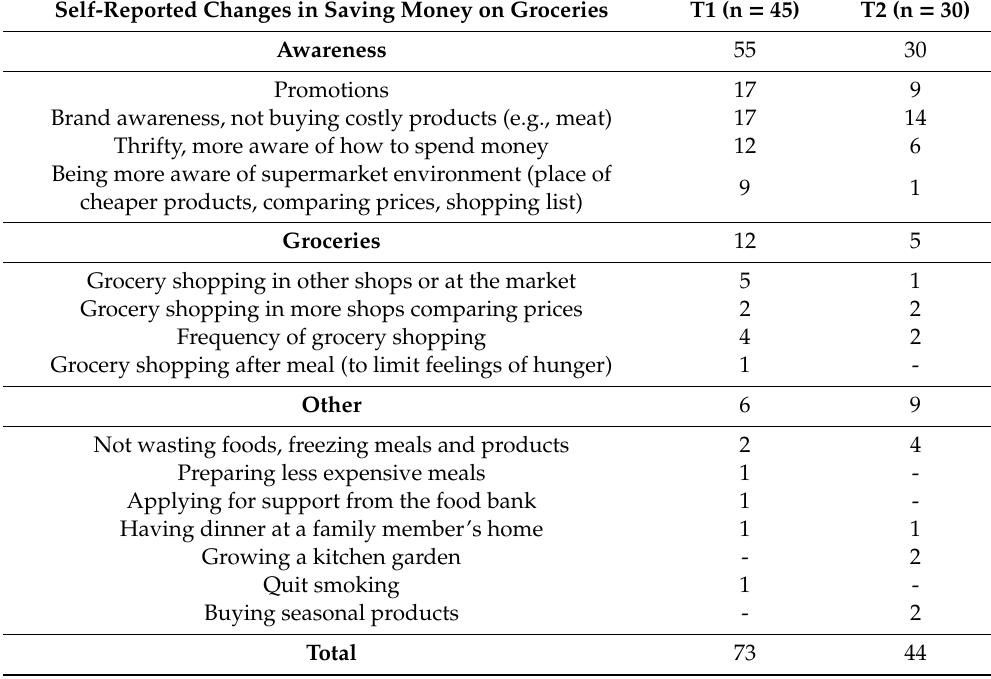
Table 5. Self-reported changes in saving money on groceries in the intervention group at post-test (T1; n = 108) and follow-up (T2; n =